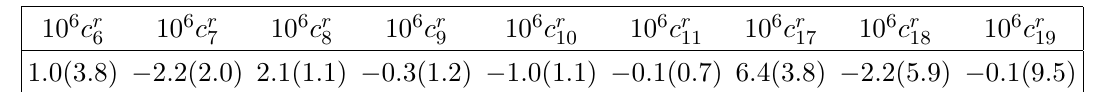
Table 3 . Numerical values of the n f = 2 LECs in (cid:14) 2 at the scale (cid:22) (cid:22) = 770 MeV extracted by combining the lattice results of [28] and the matching with the n f = 3 LECs of [45] (see appendix B for more